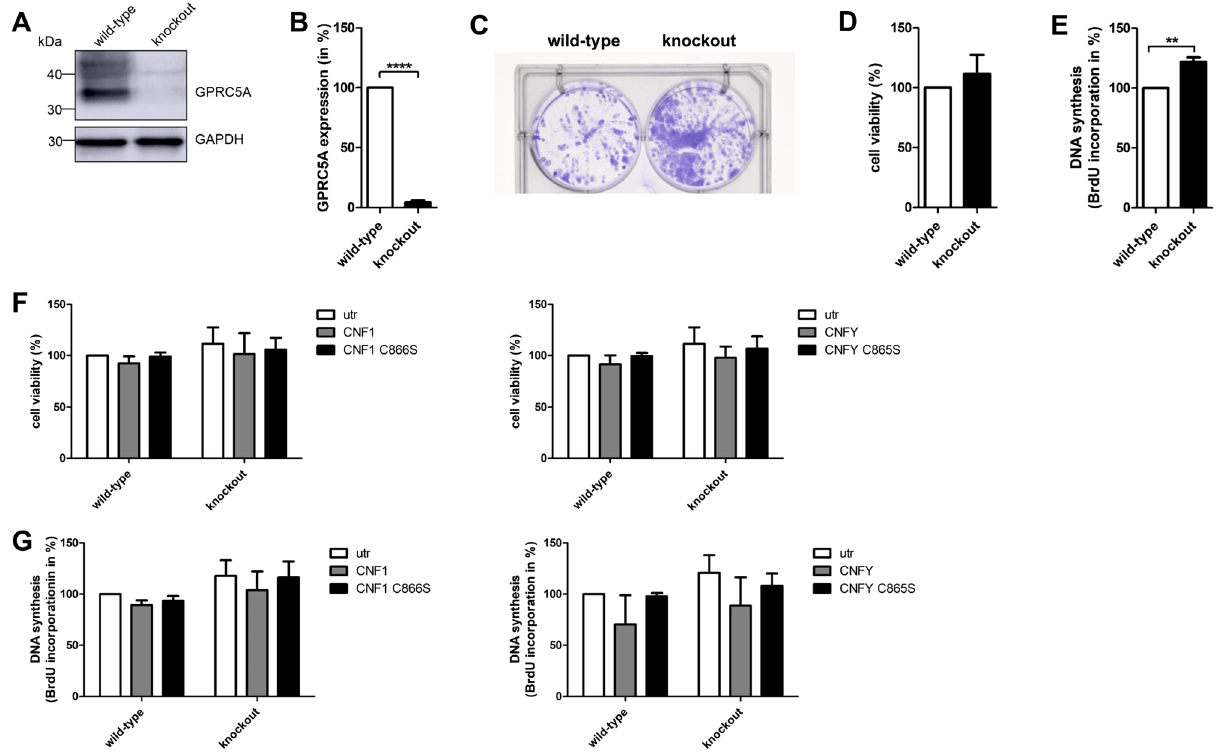
Figure 7. Knockout of GPRC5A in MDA-MB-231 cells does not inhibit proliferation. ( A ) Western Blot analysis of MDA-MB-231 wild-type and knockout cells. GAPDH was used as loading control (representative of n = 3). ( B ) Quantification of A. GPRC5A expression was normalized to GAPDH. Data of three independent experiments were analyzed using t-test. ****p < 0.0001. ( C ) MDA-MB-231 wild-type and knockout cells were grown for ten days. Cell colonies were stained with crystal violet (n = 3). ( D ) MDA-MB-231 wild-type and GPRC5A knockout cells were grown for 48 h. Cell viability was measured and normalized to the wild-type cells. Data of three independent experiments were quantified and analyzed using t-test. ( E ) MDA-MB-231 wild-type and GPRC5A knockout cells were grown for 48 h. BrdU incorporation was measured and normalized to the wild-type cells. Data of three independent experiments were quantified and analyzed using t-test. **p < 0.01. ( F ) Cell viability of MDA-MB-231 wild-type and GPRC5A knockout cells was measured after CNF intoxication for 48 h. Metabolic activity was normalized to the untreated wild-type cells. Data of three independent experiments were quantified and analyzed using two-way ANOVA. ( G ) BrdU incorporation of MDA-MB-231 wild-type and GPRC5A knockout cells was measured after CNF intoxication for 48 h. DNA synthesis was normalized to the untreated wild-type cells. Data of three independent experiments were quantified and analyzed using two-way ANOVA.